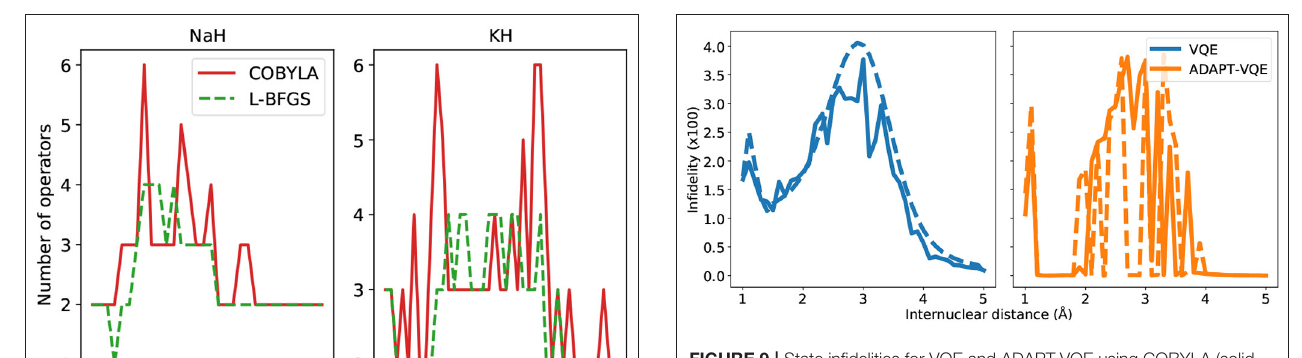
FIGURE 9 | State infidelities for VQE and ADAPT-VQE using COBYLA (solid line) and L-BFGS (dashed line) optimization with central finite differences for the KH potential energy